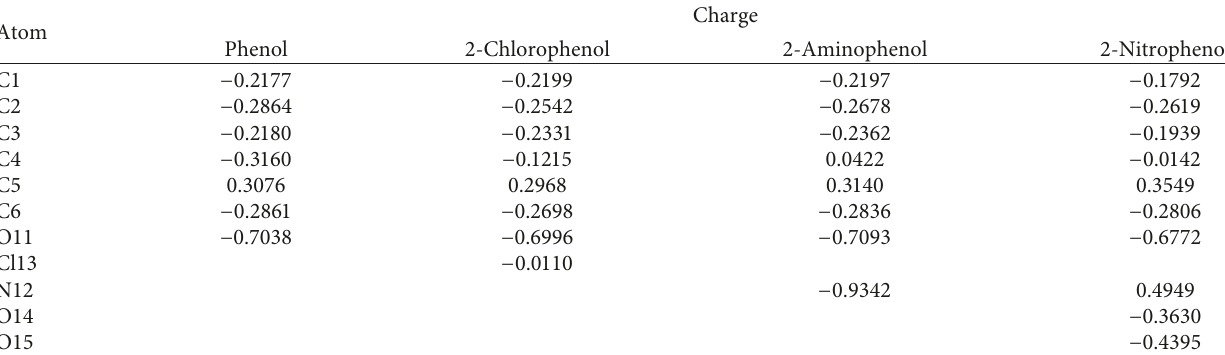
Table 6: Natural charge (atomic units) of some selected atoms in the